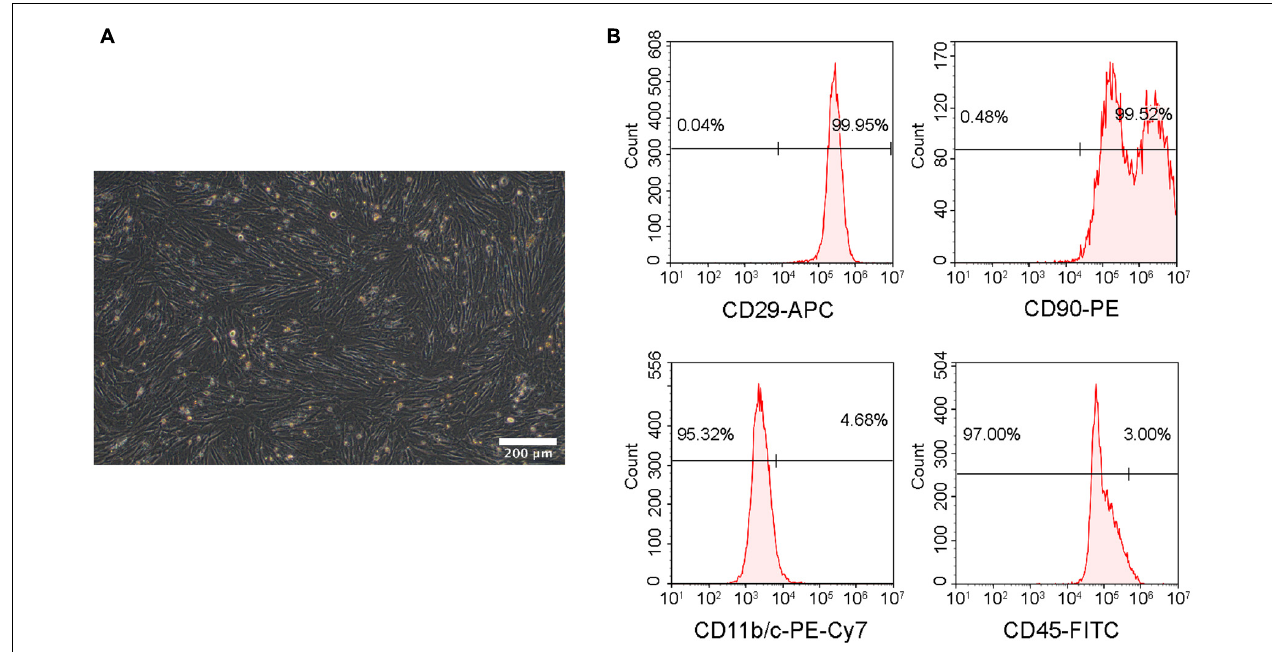
FIGURE 4 | Identification of rBMSCs. (A) Microscopic image of rBMSCs. Scale bar = 200 µ m. (B) Surface marker analysis of